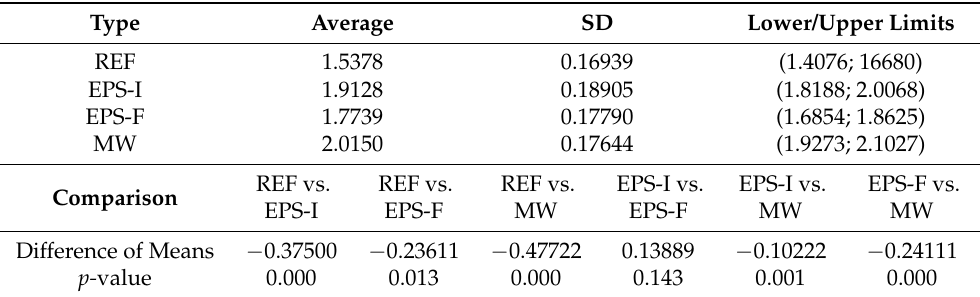
Table 15. Statistical analysis for absorption by capillarity (kg/mm 2 min 0.5 ) in each group of mortar and its comparison.